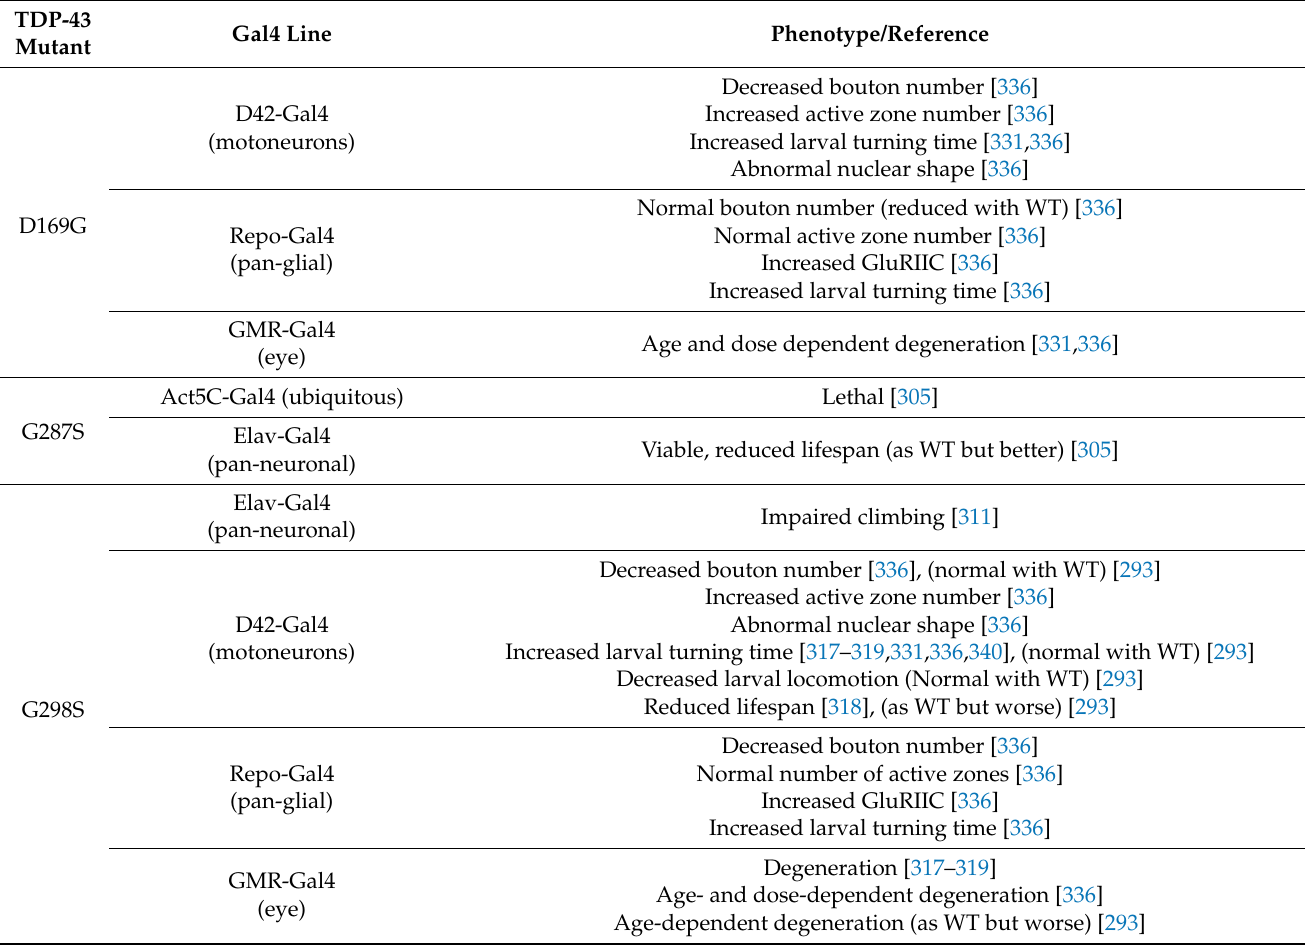
Table 13. Gain-of-function phenotypes induced by ALS-linked TDP-43